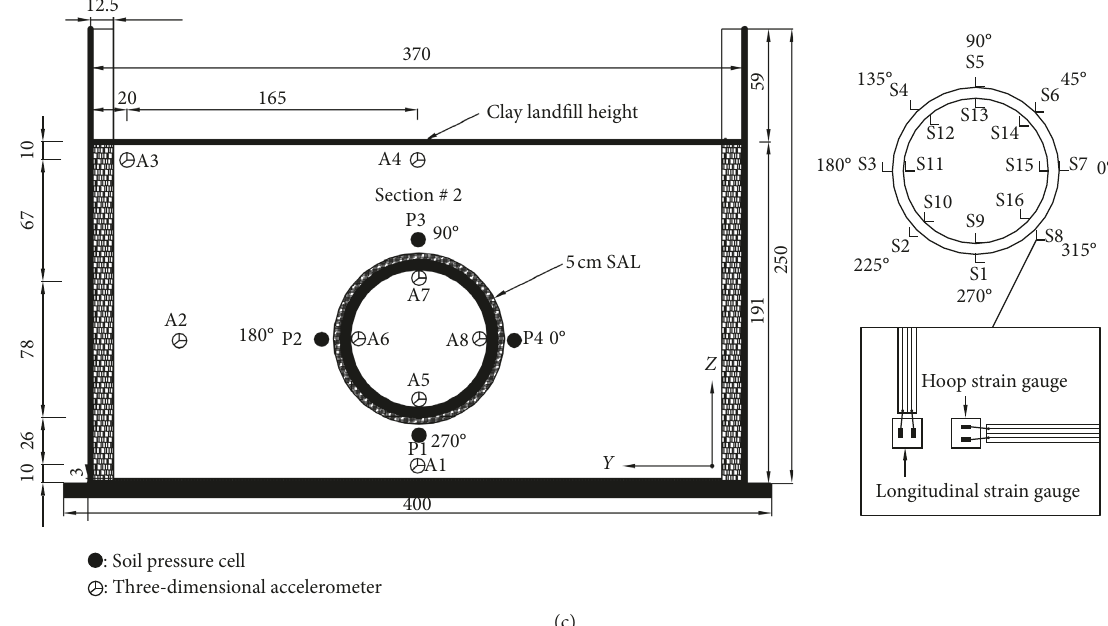
Figure 5: Instrumentation layout. (a) Profile layout. (b) Cross section # 1 layout of sensors. (c) Cross section # 2 layout of sensors (unit: cm).